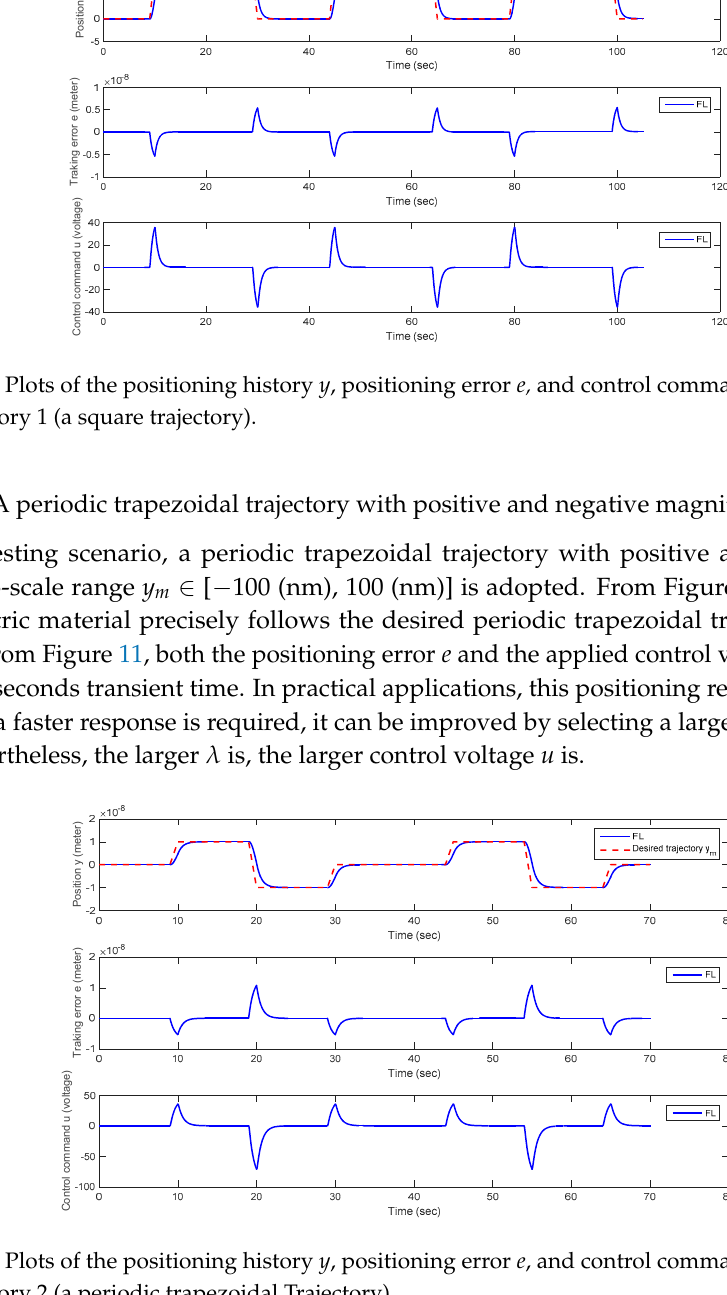
Figure 11. Plots of the positioning history y , positioning error e , and control command u versus time for Trajectory 2 (a periodic trapezoidal Trajectory).